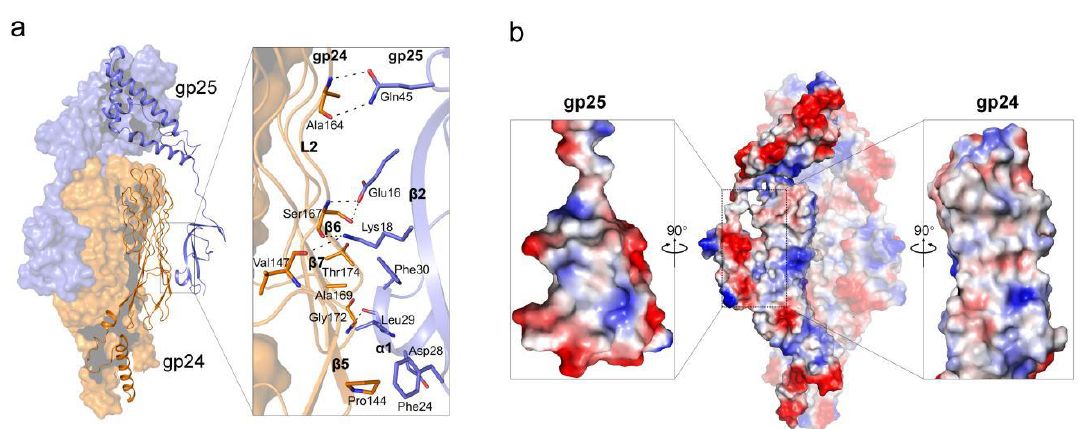
Figure 5. The interface between gp24 and gp25. ( a ) The interaction pattern between gp24 and gp25. The interface residues are shown as sticks and the hydrogen bonds are represented by black dashed lines. ( b ) The electrostatic surface potential of gp24-gp25 trimer. red, negative charged; white, neutral charged; and blue, positive charged regions (±50 kT/e). The cut-open views of the interfaces from gp25 (left) and gp24 (right) are shown as the inlets.